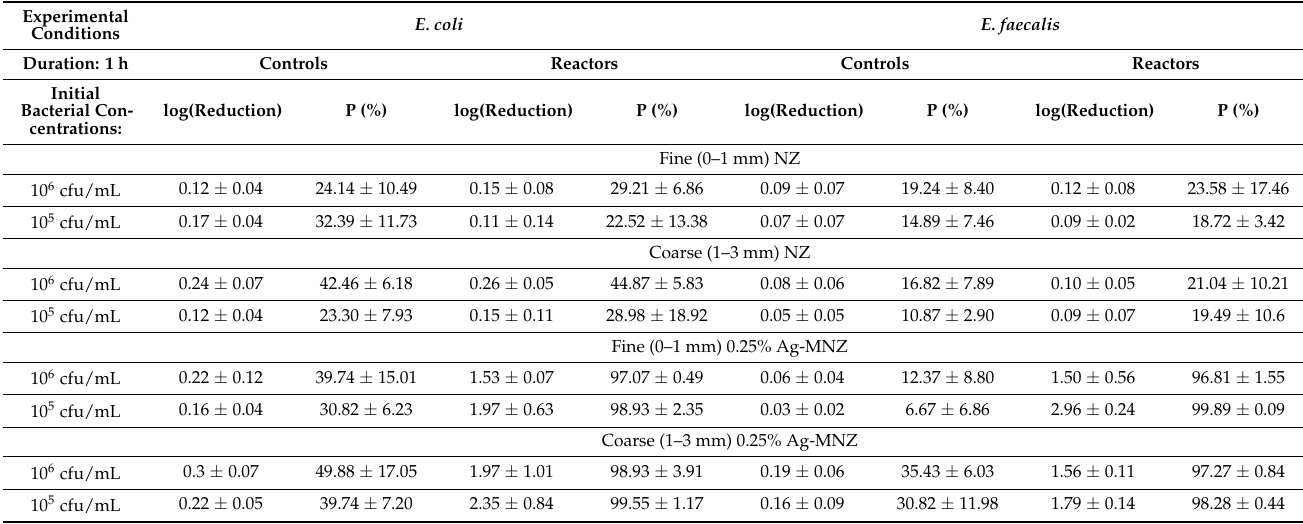
Table 2. Calculated log and percent reduction values of E. coli and E. faecalis in the presence of NZ and 0.25% Ag-MNZ within the period of 1 h under the experimental